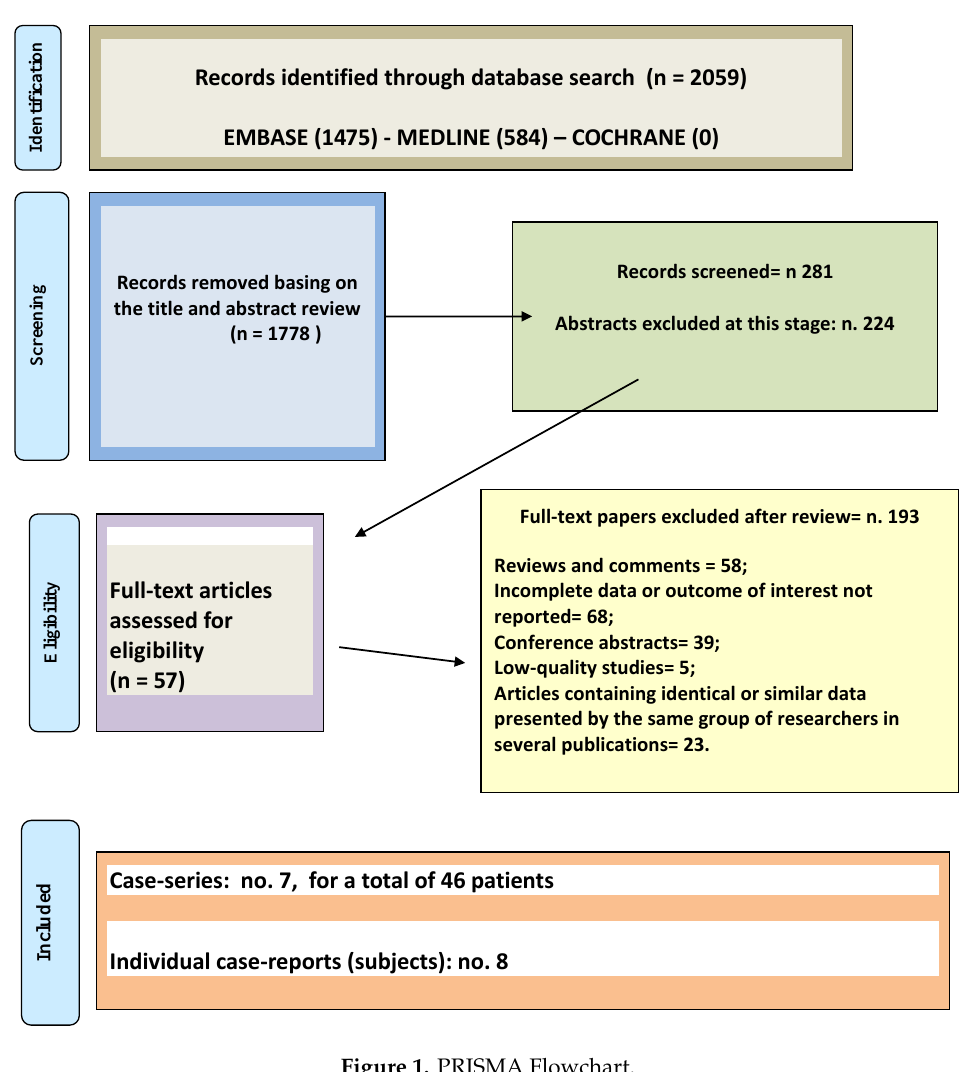
Figure 1. PRISMA